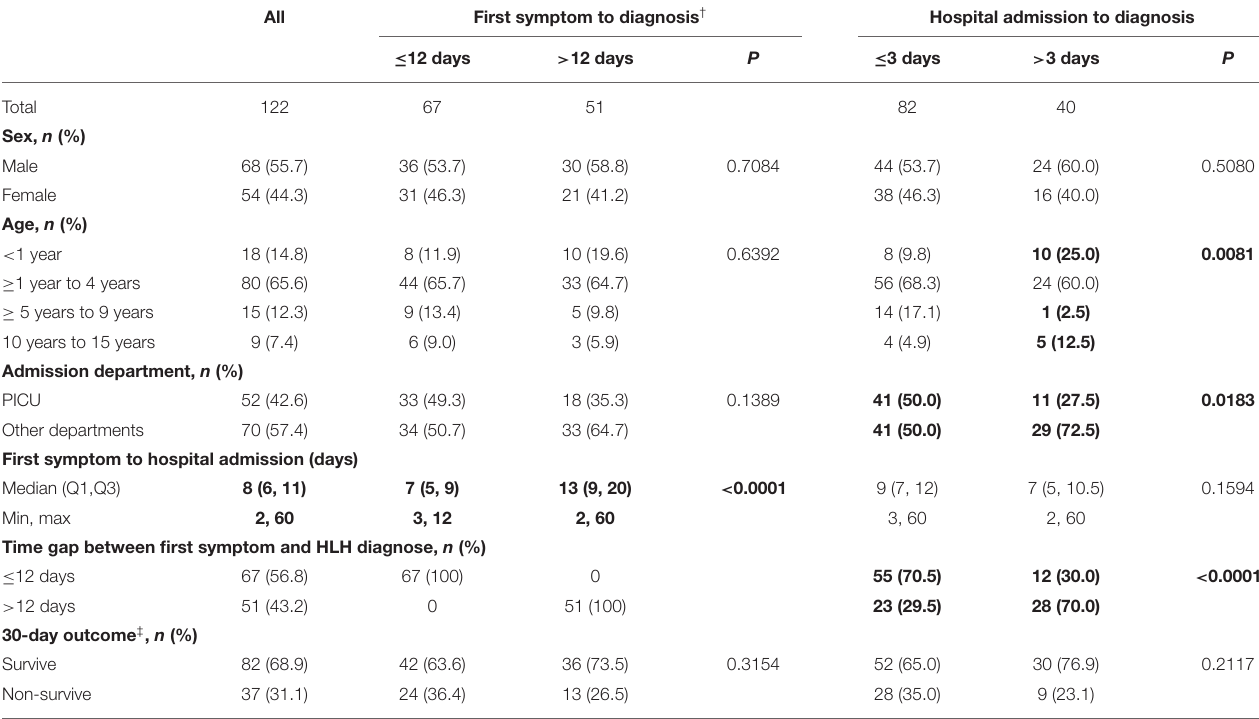
TABLE 1 | General characteristics of 122 pediatric HLH patients according to HLH diagnostic time lag categories. All First symptom to diagnosis